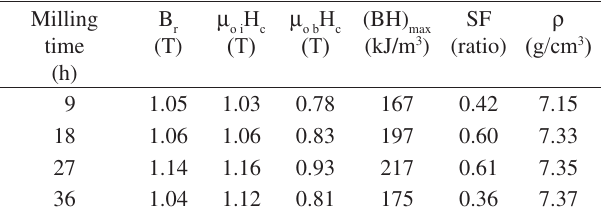
Table 3. Magnetic properties of Pr der milled for 20 hours and sintered at various temperatures. (error: ± 2%). Sintering